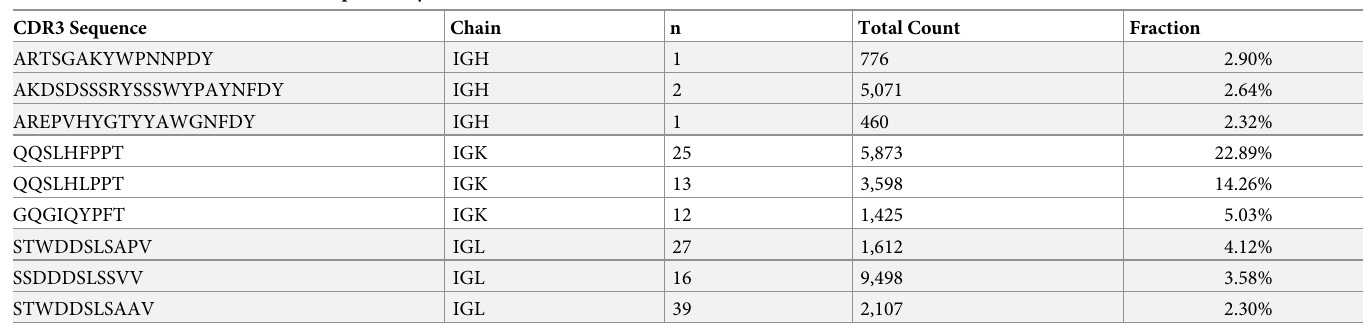
Table 3. Three most common CDR3 sequences by chain.